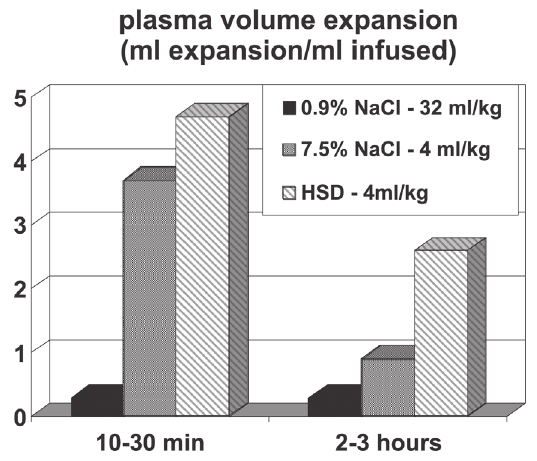
Figure 2 - Plasma volume expansion in ml expansion per ml infused after 32 ml/kg isotonic NaCl, 4 ml/kg 7.5% NaCl, or 4ml/kg 7.5% NaCl-6%Dextran-70.